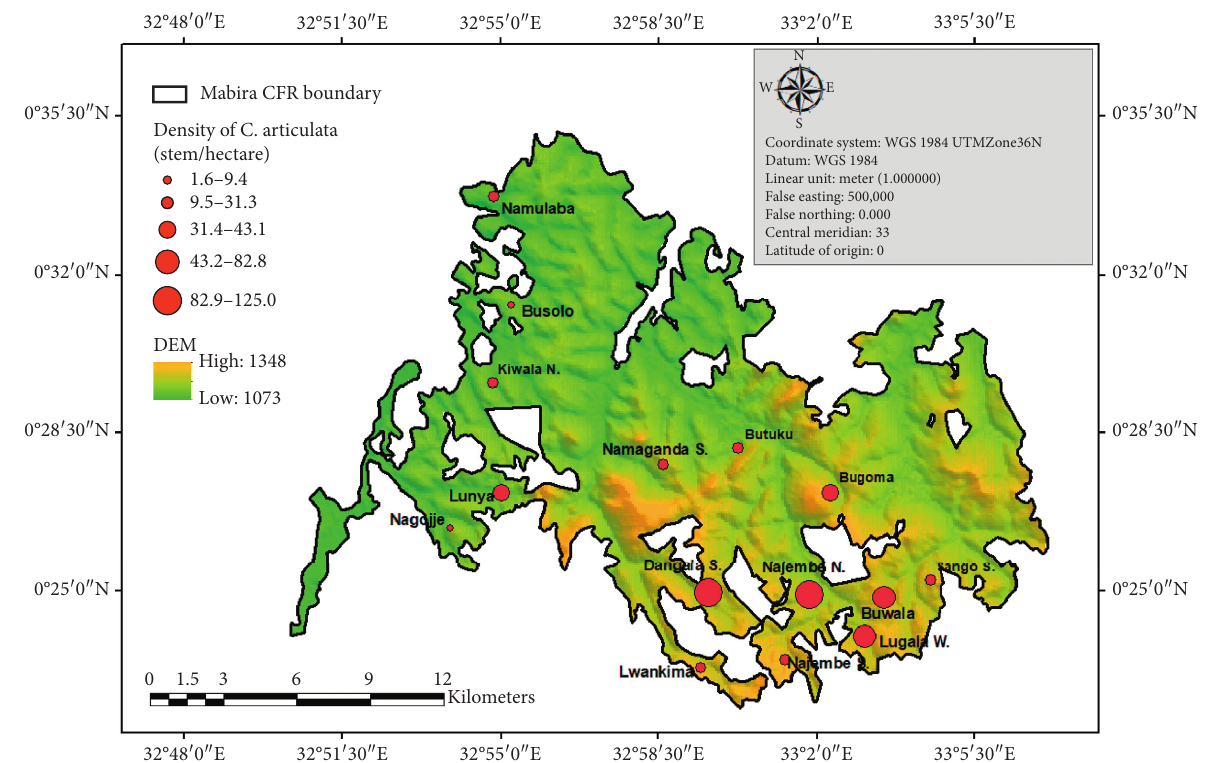
Figure 2: Variability in occurrence of C. articulata in Mabira Central Forest